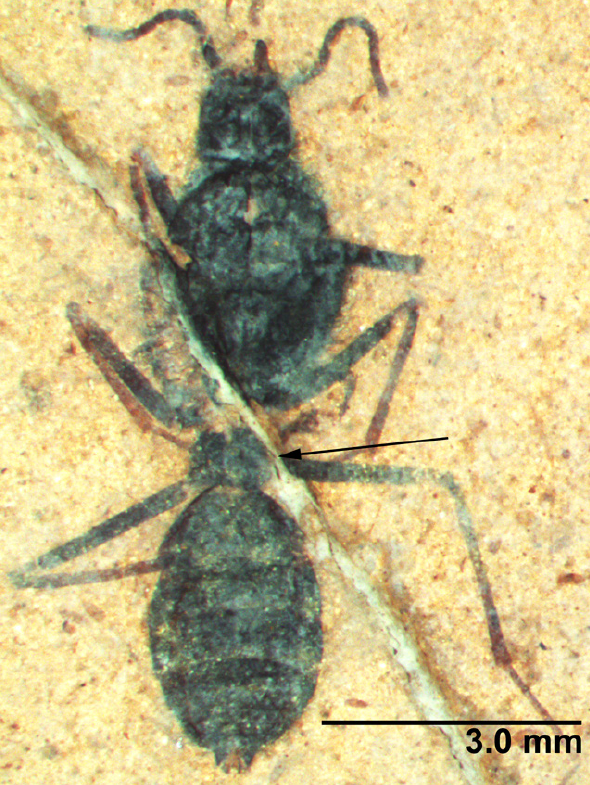
Fig 13 . Holotype male, Eoformica brevipetiola (USNM# 609610). Fig 14 . Holotype male, Eoformica latimedia (USNM#